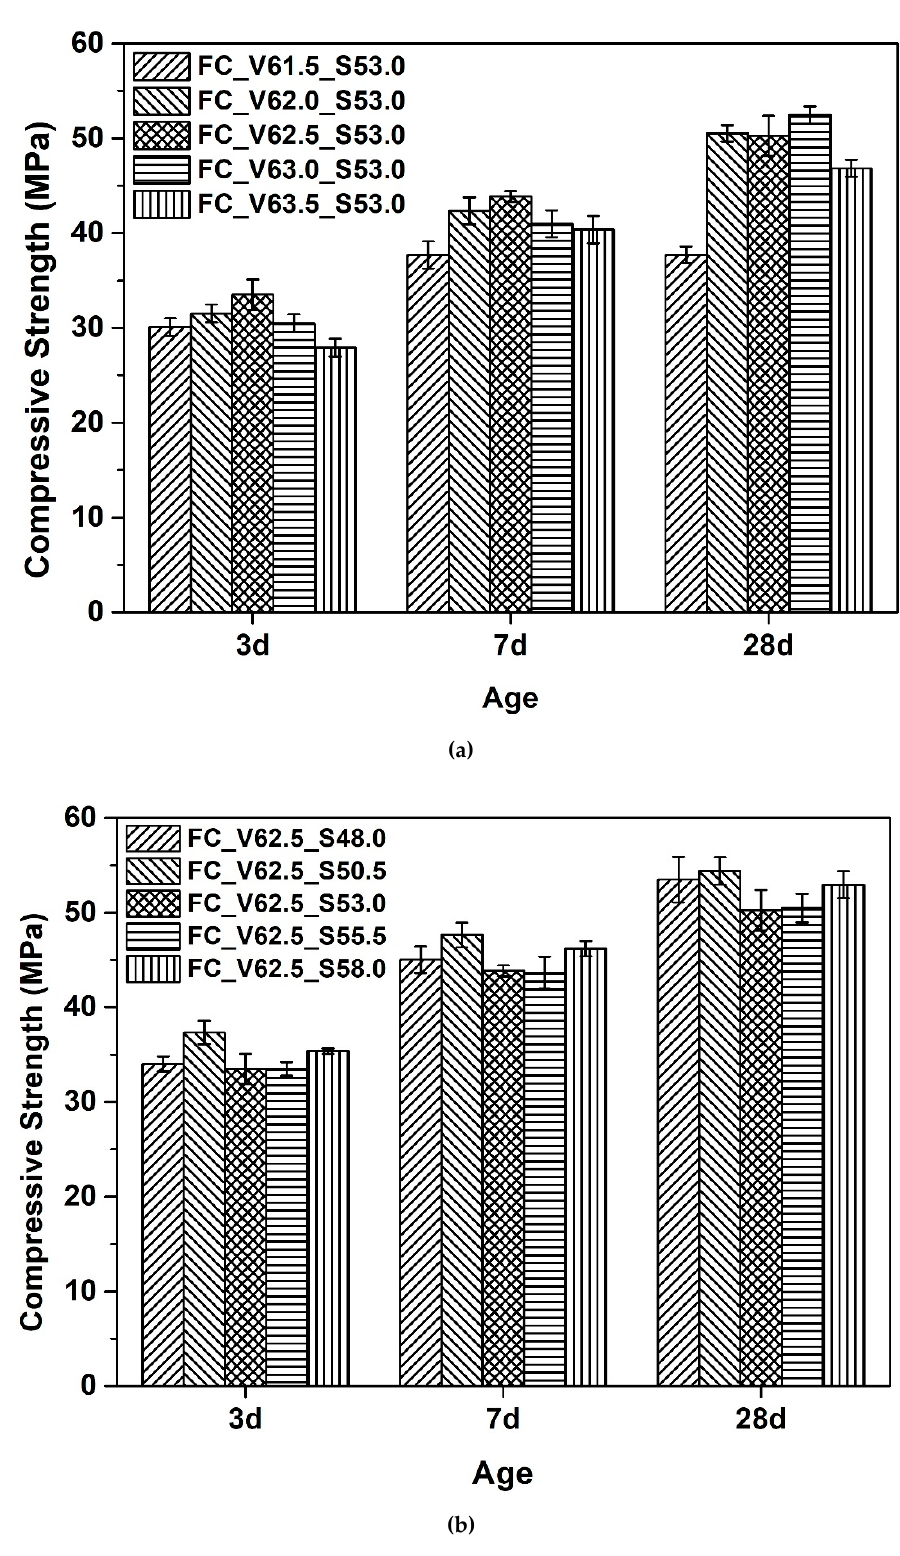
Figure 8. Influence of aggregate volume fraction ( a ) and sand to total aggregate volume ratio ( b ) on compressive strength of fluid concrete mixtures.